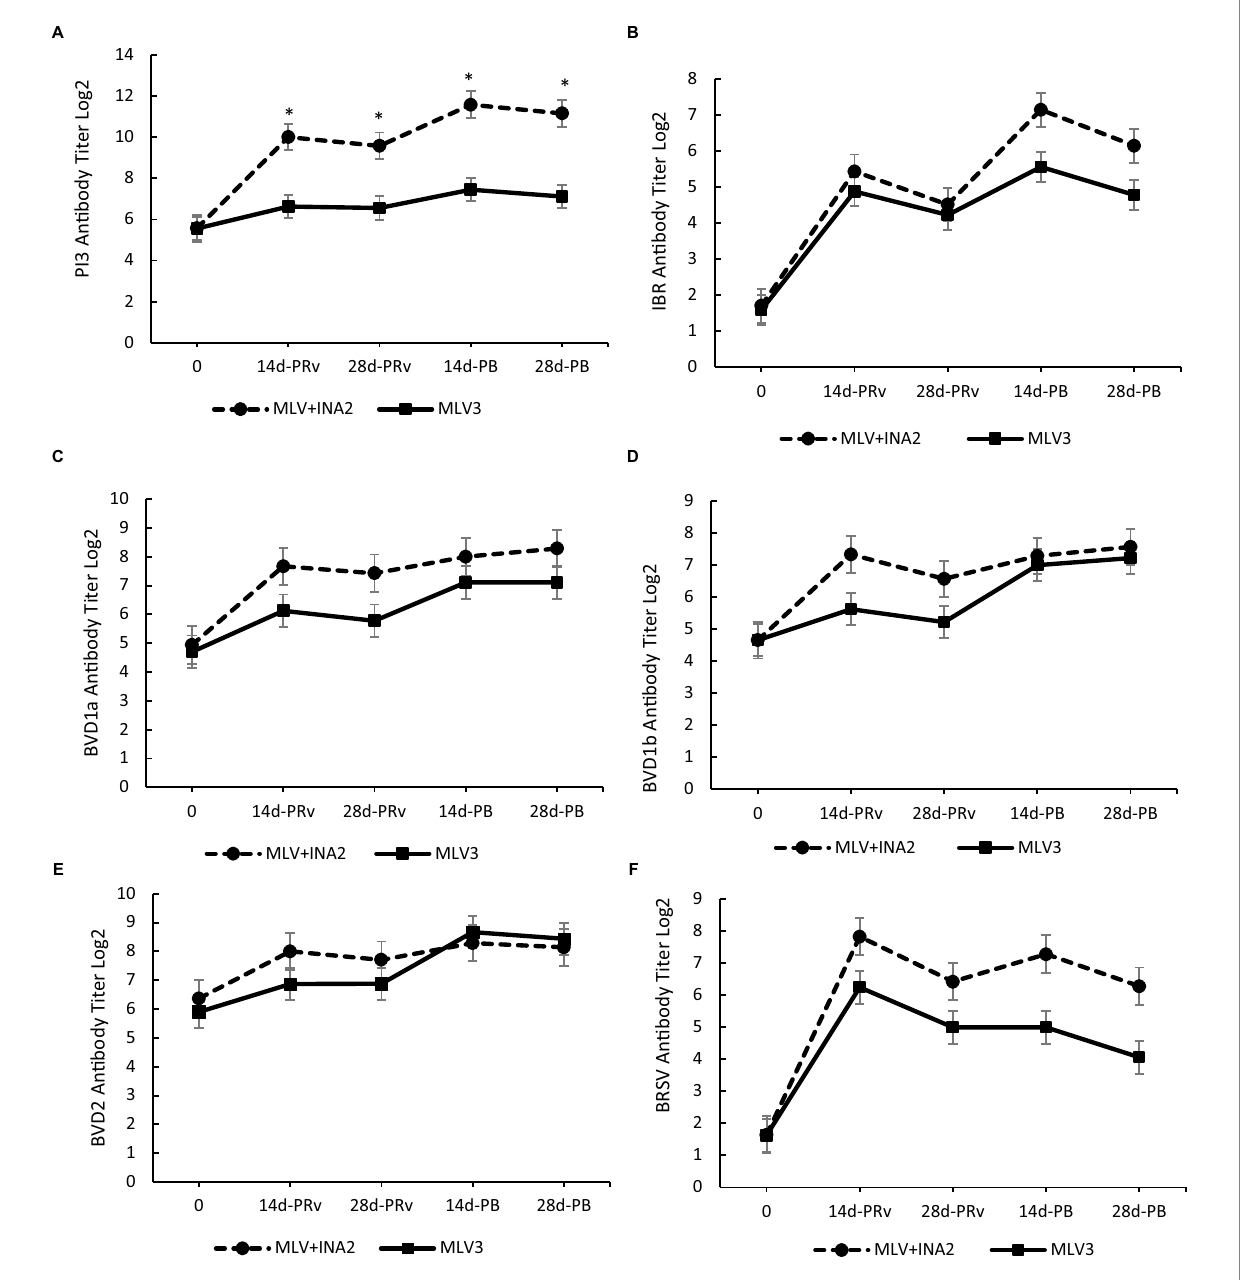
FIGURE 2 Effect of vaccine treatment by day on serum neutralization antibody titers for Parainfluenza 3 (A) at 14 and 28 days post-revaccination (PRv) and post- booster (PB) Treatment × Day interactive = p < 0.0001. No effect of vaccine treatment by day was found for serum neutralizing antibody titers for Infectious Bovine Rhinotracheitis (B) , Bovine Viral Diarrhea Virus type 1a (C) , 1b (D) or 2 (E) , or Bovine Respiratory Syncytial Virus (F) . Data are expressed as means ± standard error of the mean. Means between treatments within a day with * differ at p <